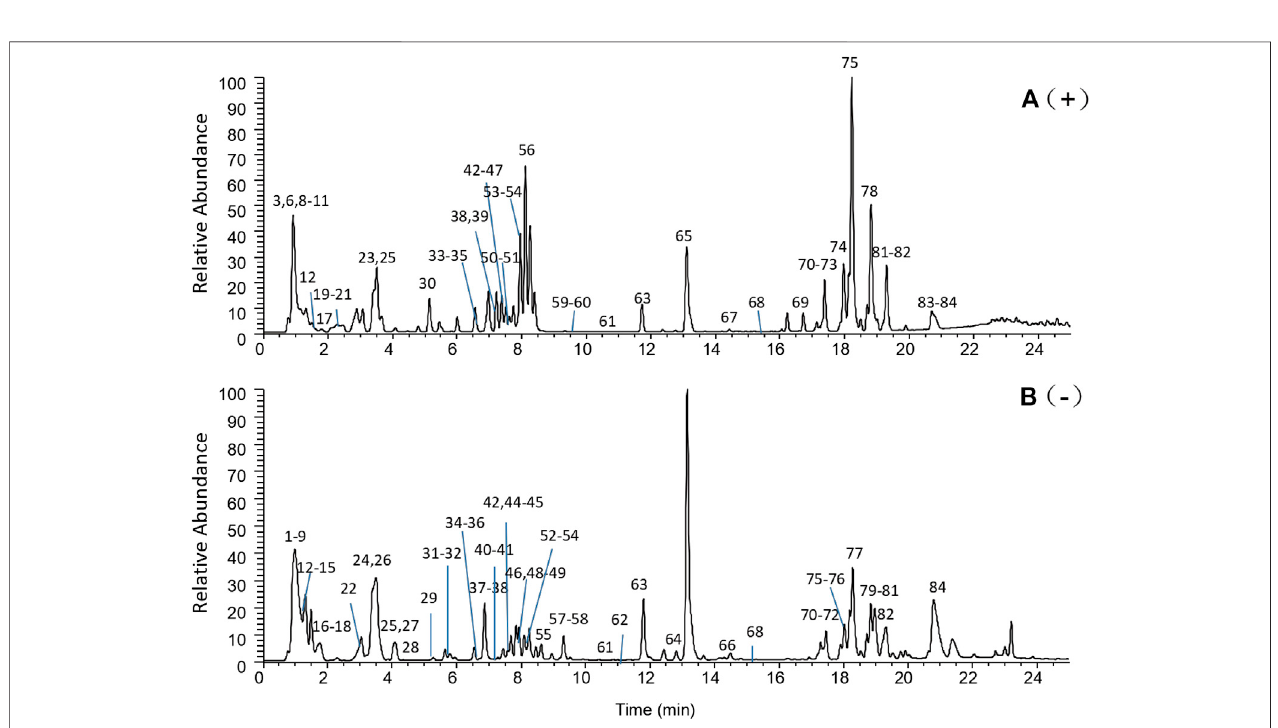
FIGURE 4 | Total ion chromatogram of MCXZ detected by UHPLC-LTQ-Orbitrap. (A) : Positive ion detection mode; (B) : Negative ion detection mode.